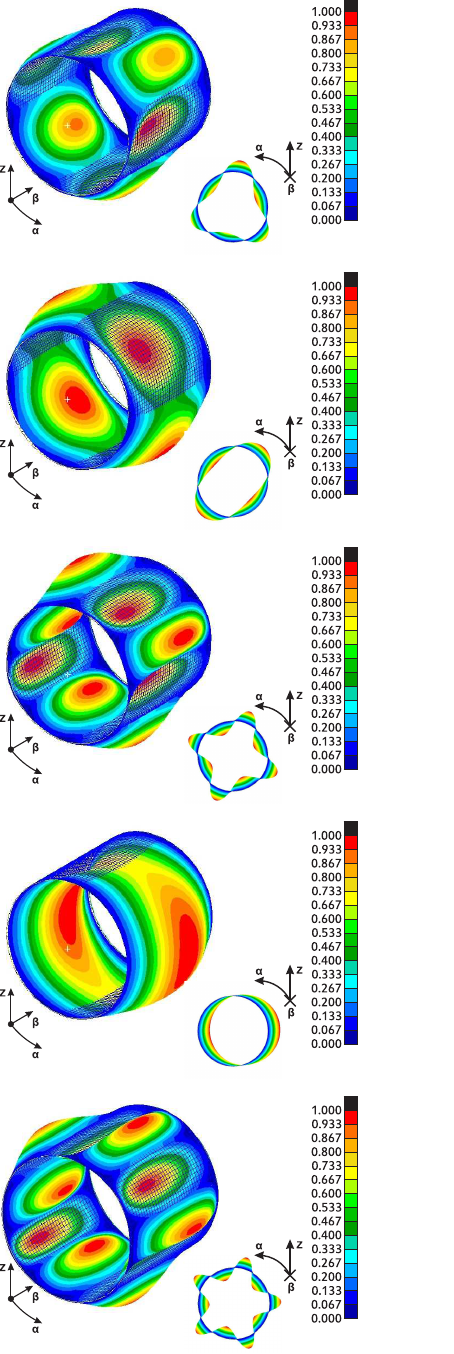
frequencies that are smaller than 3D results, and this fea- ture demonstrates how the code does not work in a cor- rect way for such a benchmark. The plate is isotropic in the plane and for this reason the vibration behavior is a